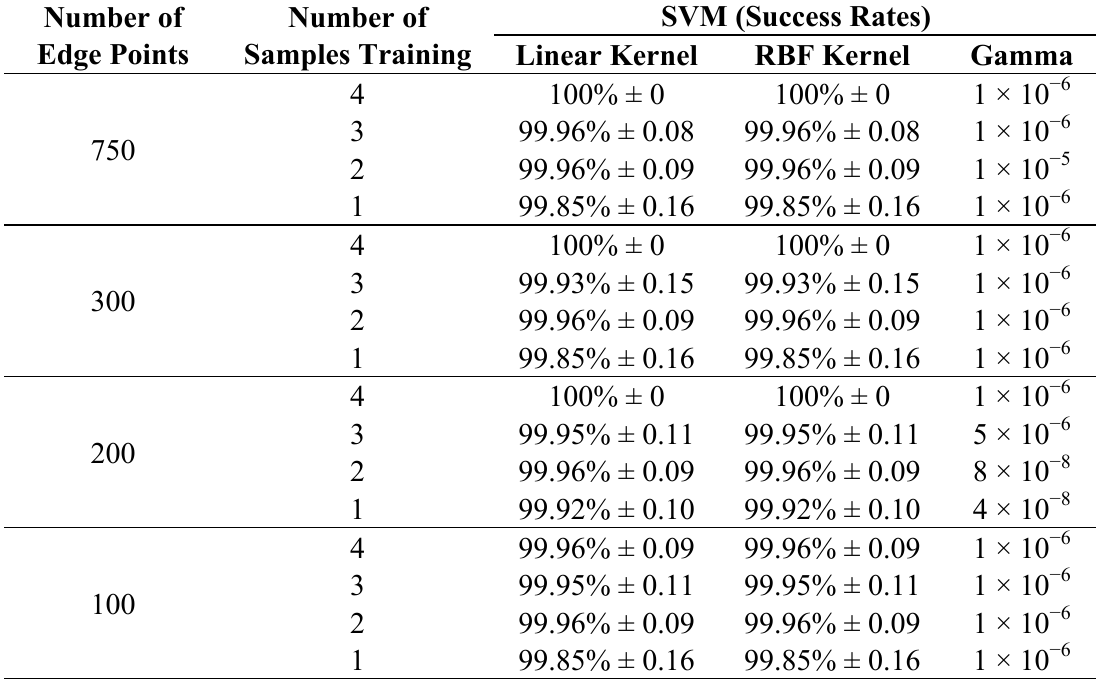
Table 3. Success rates for the SVM classifier, using HMM kernel for 60